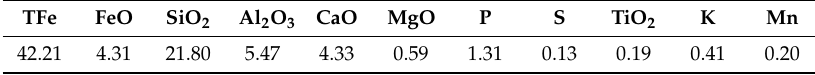
Table 1. Chemical composition analysis of oolitic hematite ore (wt %).